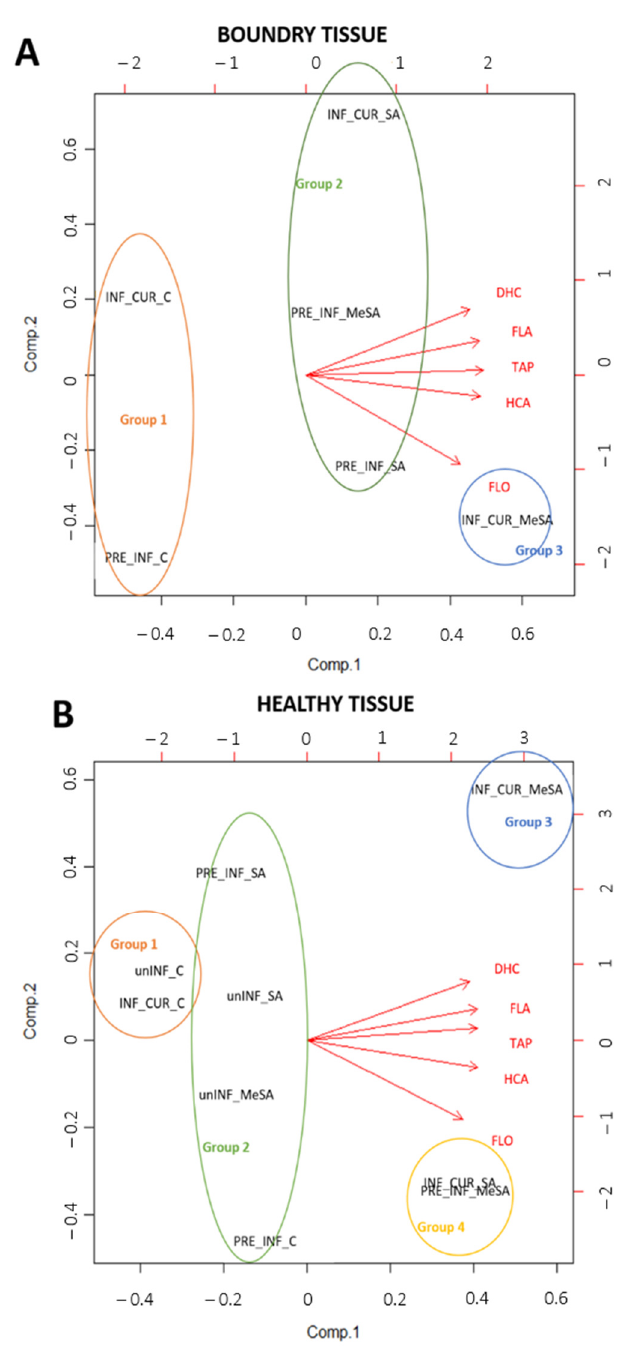
Figure 4. Biplot corresponding to PCA for apple peel boundary tissue around lesion caused by M. laxa ( A ) and healthy tissue ( B ), treated preventively (pre) or curatively (cur) with salicylic acid (SA) and methyl salicylic acid (MeSA). INF, infected; unINF, uninfected; FLO, flavonols; FLA, flavanols; HCA, hydroxycinnamic acids; DHC, dihydrochalcones; TAP, total analyzed phenolics. Groups 1 to 4: grouping of samples based on multivariate analysis .